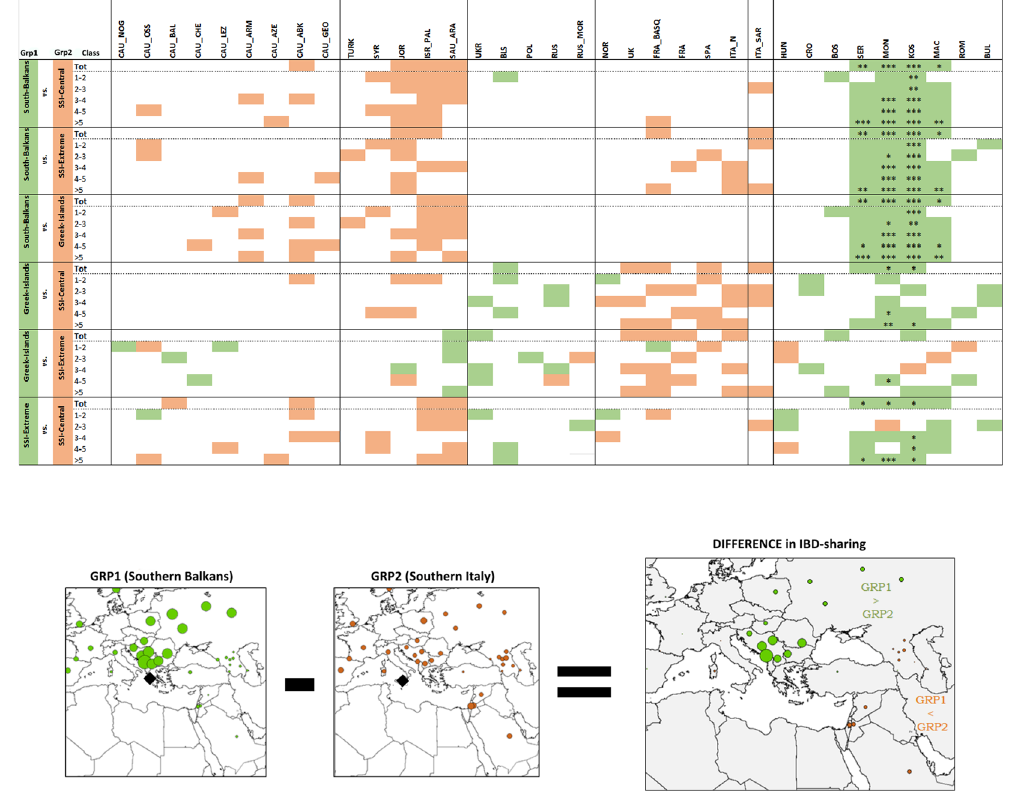
Figure 4. Differences in IBD-sharing between Southern Italian and Southern Balkan population groups. Vectors of IBD-sharing with the 35 comparison populations reported on the x-axis were pairwise subtracted between pairs of Southern Balkan and/or Southern Italian population groups. The plots at the bottom of the figure provide a schematic representation of the pairwise-subtracting procedure ( left : IBD-sharing of a Southern Balkan group with all comparison populations; centre : IBD-sharing of a Southern Italian group with all comparison populations; right : difference in IBD-sharing between the two considered groups). Comparison populations for which we observed differences in IBD-sharing between the two tested groups exceeding the lower (0.10 percentile) or the upper (0.90 percentile) bounds of the distribution are marked by coloured boxes in the table ( green : Grp1 > Grp2, red Grp2 > Grp1). Significant differences in IBD-sharing, after the grubbs.test for significance (R software package outliers [v. 0.14] Komsta, L. Outliers: Tests for outliers. R package version 0 . 14 . URL: https://CRAN.R-project.org/package = outliers (2011)), are indicated by